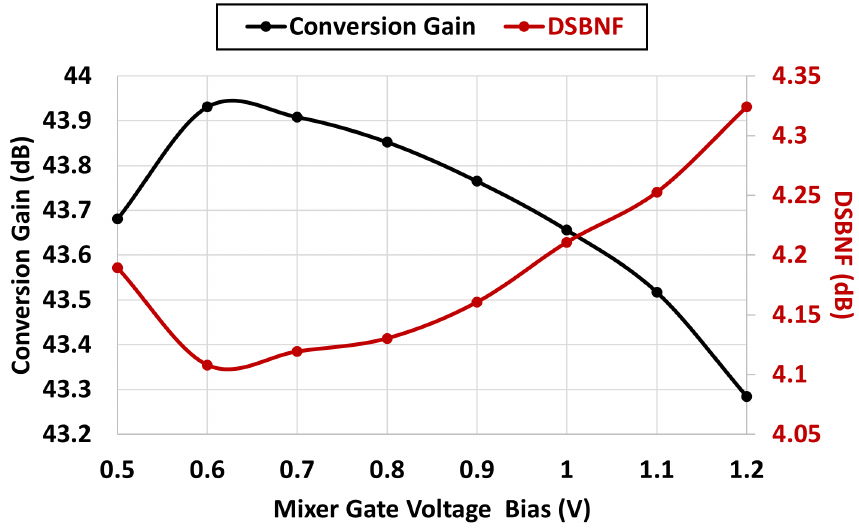
Figure 10. The NF and conversion gain versus the gate bias voltage of the mixer. The performance of the CRR front-end needs to be verified across a wide supply volt- age range since the current-reuse architecture depends on the available voltage headroom. Figure 11 shows the NF and conversion gain performance versus the supply voltage sweep from 1 V to 1.5 V. It shows a very stable performance versus the supply variations. The conversion gain changes by almost 3 dB from a supply going from 1.1 V to 1.3 V, and the NF is almost constant at 4.1